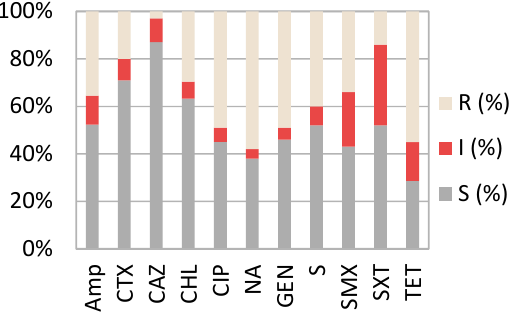
Figure 1. Antimicrobial susceptibility of pathogenic strains. R—resistant; I—intermediate; S—sus-